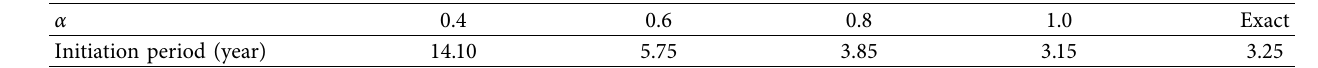
Table 3: Initiation period of corrosion under different α .